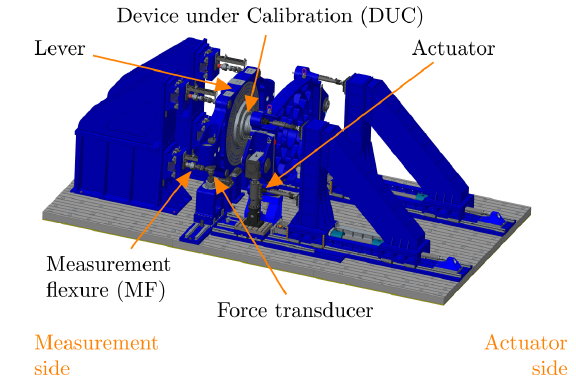
Figure 1. The 5MNm TSM set-up.